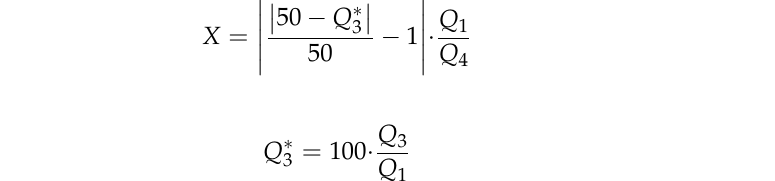
Figure 8. Jet pump dimensioning and optimization methodology [2].